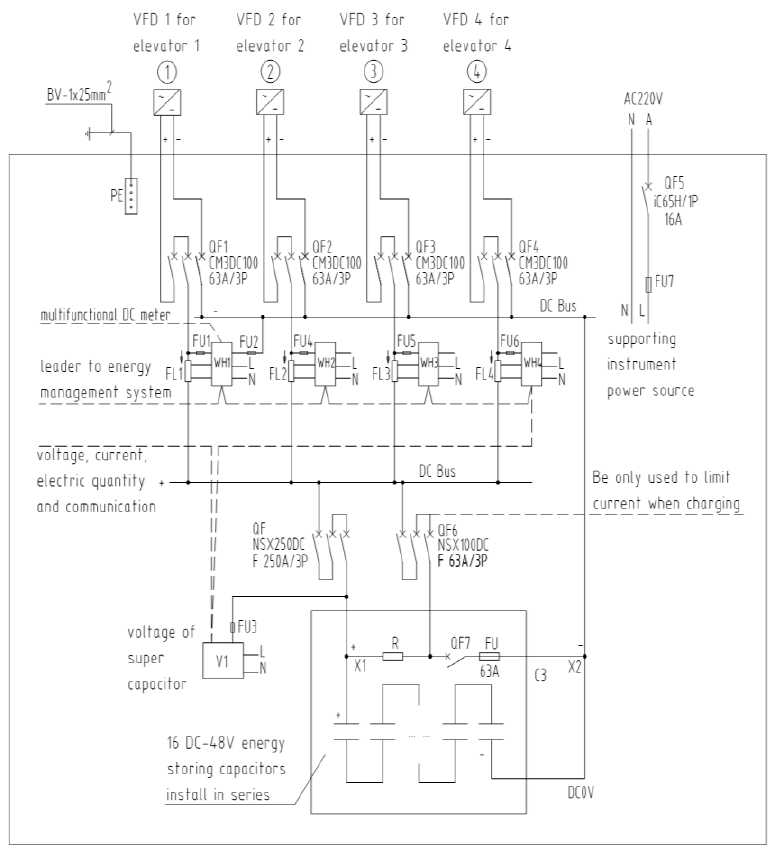
Figure 9. The design of the elevators DC micro-grid system.